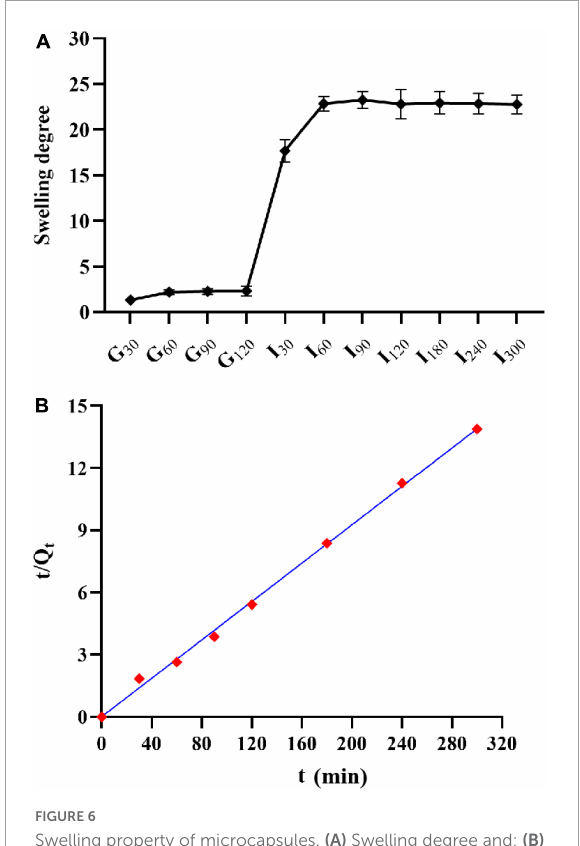
FIGURE6 Swelling property of microcapsules. (A) Swelling degree and; (B) the relationship between the reciprocal t/Qt and t of the swelling degree of AC microcapsules.